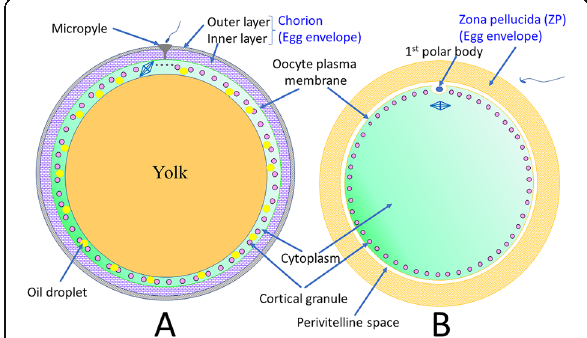
Fig. 1 Schematic illustrations of ovulated fish (medaka) and mouse eggs ( A and B , respectively). The fish (medaka) egg envelope, also known as the “ chorion, ” “ zona radiata, ” and/or “ vitelline envelope, ” is shown with its two layers — the inner layer (interna) and the outer layer (externa). The single-layer egg envelope in mammals is termed the “ zona pellucida